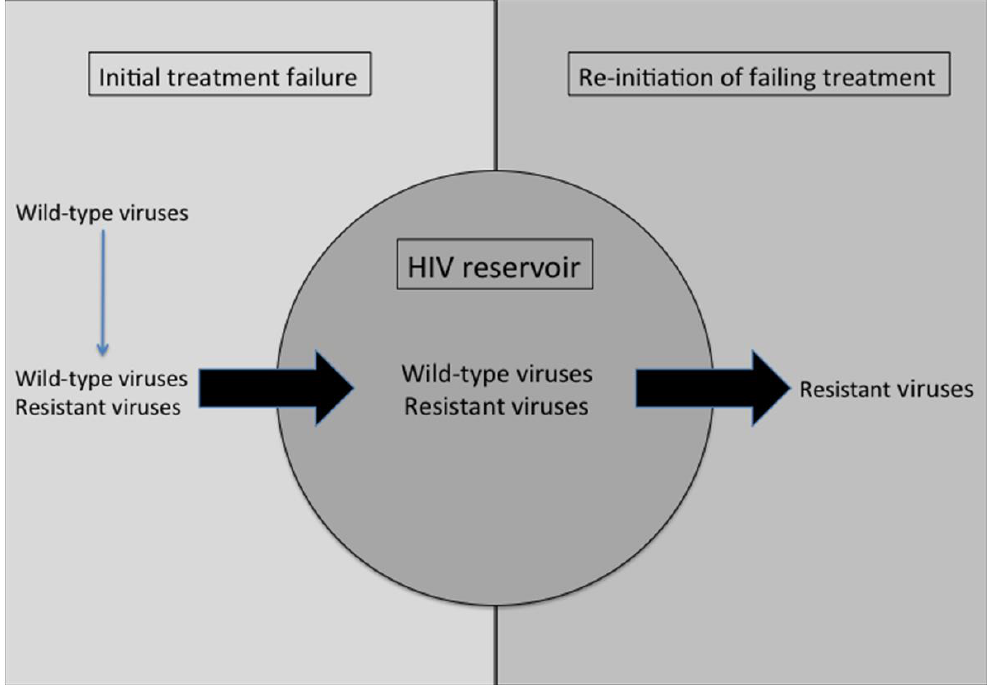
Figure 1. HIV resistant viruses are archived within the viral reservoir upon treatment failure and can rapidly reemerge following treatment re-initiation.